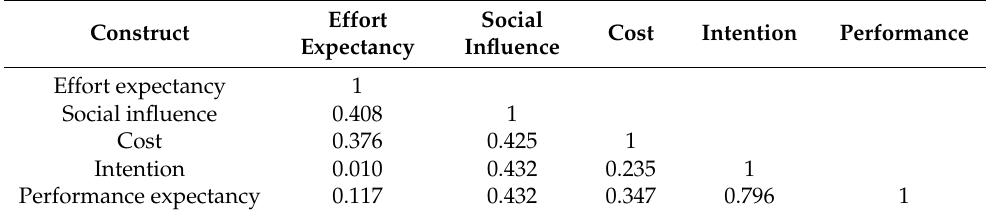
Table 3. Correlation.